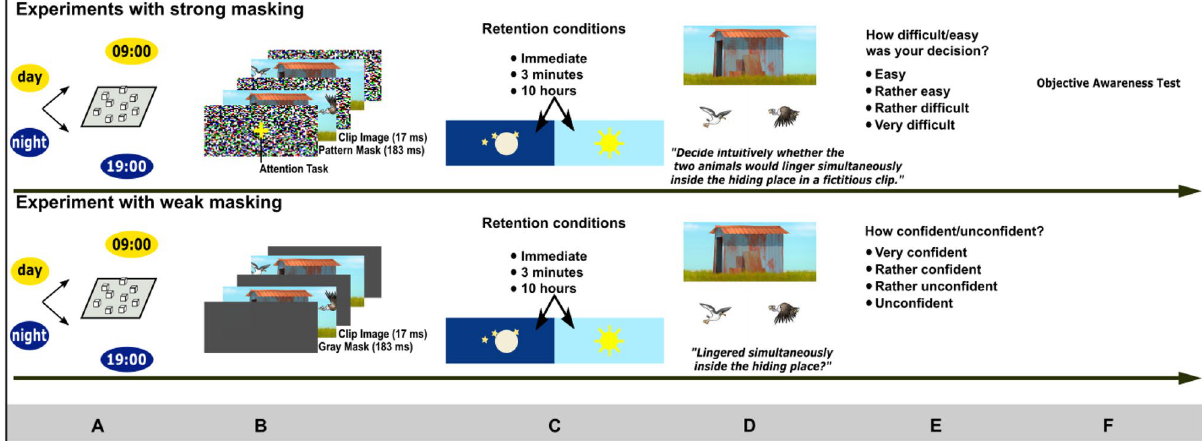
Figure 1. Experimental design. ( a ). Encoding took place in the morning or in the evening. Before encoding, participants performed the Corsi block-tapping test backwards to assess the visuospatial working memory capacity. ( b ) Clips were presented strongly masked for unconscious encoding and weakly masked for conscious encoding. When masking was strong, participants performed a central attention task during clip presentation. Every cartoon frame was repeated three times in sequence but for display purposes, a frame is depicted only once. ( c – e ) Six of the 18 displayed clips were randomly assigned to each of the three retention conditions ( c ). Retrieval trials ( d ) and confidence/difficulty ratings ( e ) were prompted immediately after clip offset or following three minutes or following 10 h. ( f) When clips were presented subliminally, we administered an objective test of clip awareness at the end of the experiment.